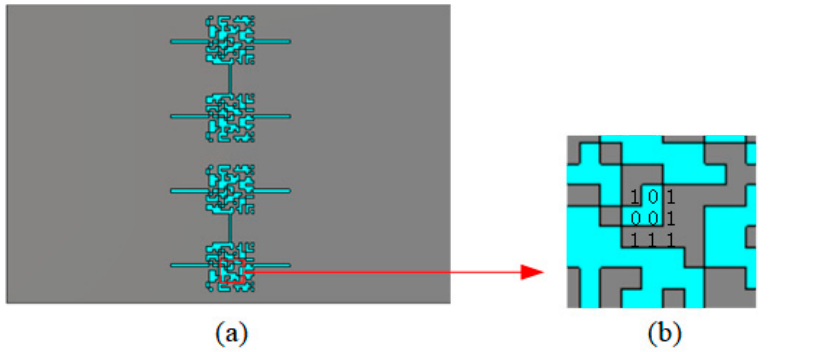
Figure 3. The structure of the AGA-optimized sensor: ( a ) the structure and ( b ) the details of the copper patch.